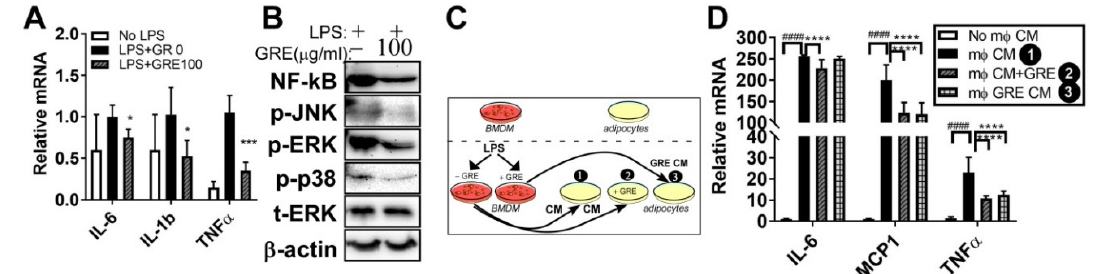
Figure 5. GR extracts attenuated the LPS-induced inflammatory responses in 3T3-L1 adipocytes and adipocytes exposed to macrophage-conditioned media (CM). The 3T3-L1 cells were seeded and induced to di ff erentiation in the presence of dimethyl sulfoxide (DMSO, vehicle control) and GRE (100 µ g / mL) for 7 days and then starved in DMEM for 12–18 h, followed by LPS stimulation (100 ng / mL, 2h) in the presence or absence of GRE. ( A ) IL-6, IL-1 β , and TNF α gene expression by qPCR. ( B ) Protein extracts from LPS-treated 3T3-L1 adipocytes in the presence or absence of GRE (100 µ g / mL) were immunoblotted with antibodies targeting NF-kB, p-JNK, p-ERK, p-p38, t-ERK, or β -actin (loading control); 3T3-L1 adipocytes were preincubated with DMSO or GRE before receiving the CM of LPS-treated BMDMs with or without GRE. ( C ) Experimental scheme. ( D ) IL-6, MCP1, and TNF α gene expression by qPCR. All values are presented as the mean ± SEM ( n = 3–4 / group for each experiment). #### p < 0.0001; compared with non-macrophage (m φ ) CM vs. m φ CM. * p < 0.05; *** p < 0.001; **** p < 0.0001 compared with LPS-treated group or m m φ CM vs. GRE-treated group by one-way ANOVA with Bonferroni’s comparison test. + , treatment; − , non-treatment.